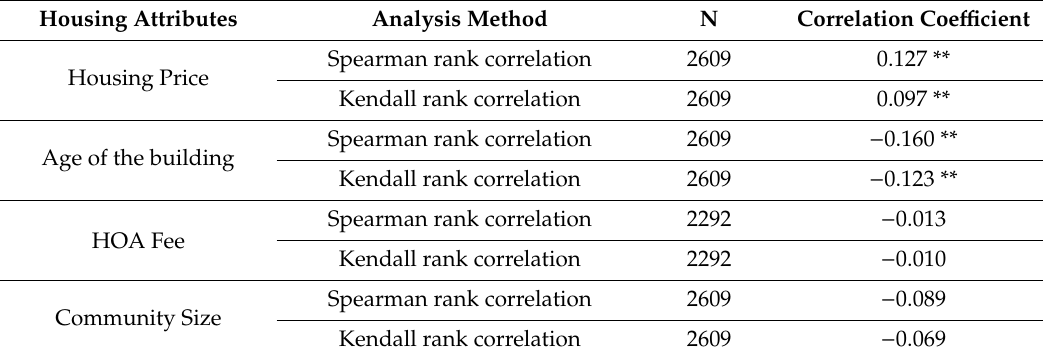
Table 4. Correlation between accessibility and housing attributes in